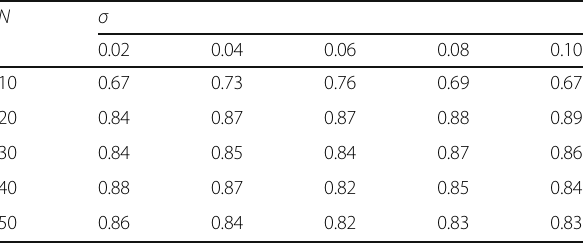
Table 7 The influence of the horizontal grouping of simulation dataset in the GVCA method on the classification